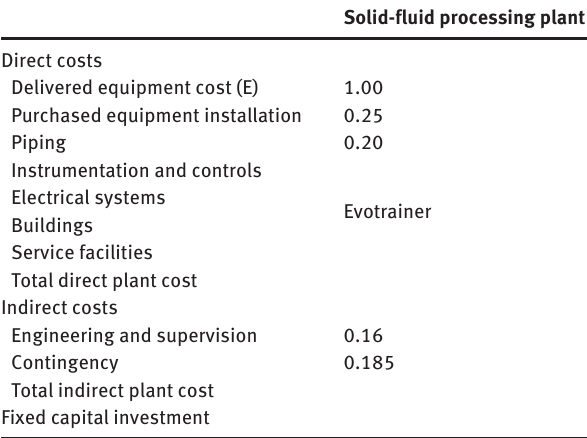
Table 3 Fixed capital investment determination based on detailed factorial estimate method for the “Evotrainer” scenario (as given by Peters et al.